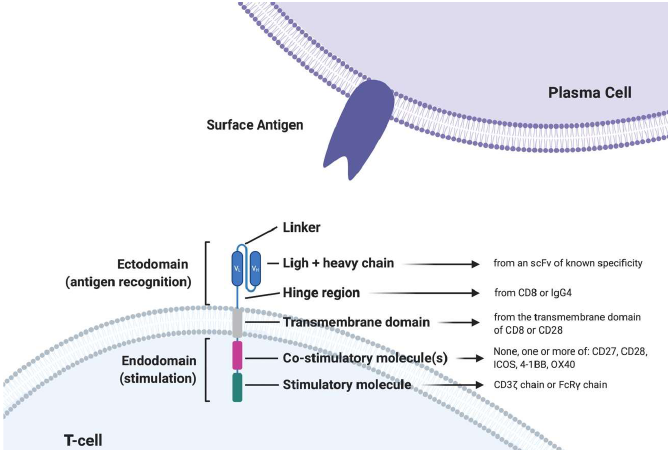
Figure 1. Structure of a second generation chimeric antigen receptor T cell (CAR T-cell). scFV: single chain variable fragment; FcR γ : Fc gamma receptor.4-1BB: also called CD137 or TNFRS9, activation-induced costimulatory molecule; iCOS: inducible T-cell